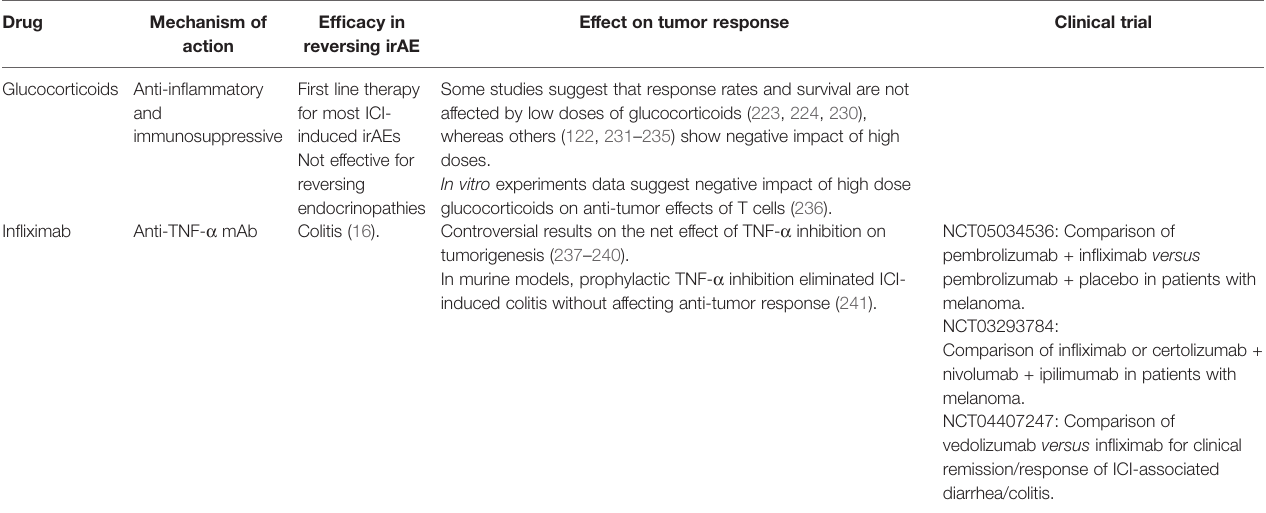
TABLE 2 | Therapies used for immune adverse events associated with immune checkpoint